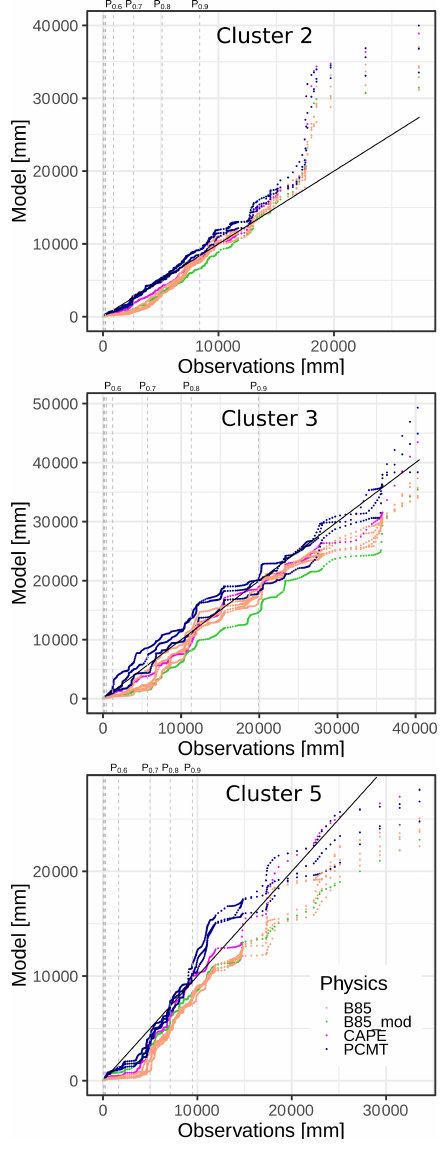
Figure 13. Quantile–quantile plot between SAL pattern rain amounts from the model ( Y axis) and from the observation ( X axis). Physics schemes are gathered into four classes (B85, PCMT, B85 mod , CAPE). Observation deciles correspond to the vertical dashed